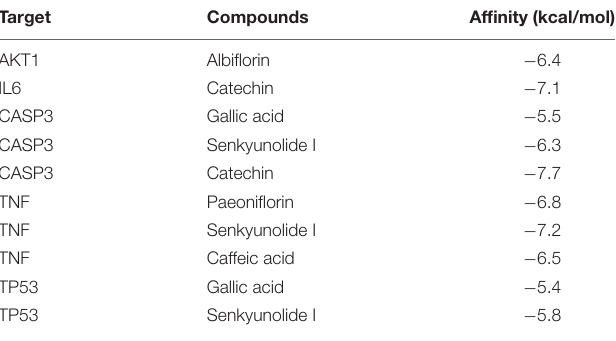
TABLE 2 | Molecular docking of active compounds and core targets in